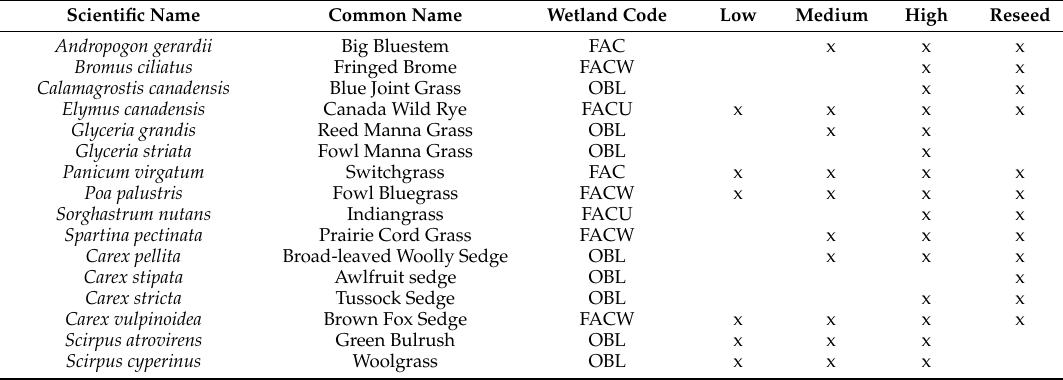
Table 2. List of plant species planted in the treatment wetland in 2013. High, medium, and low diversity seed mixtures are indicated along with a 23-species mixture for reseeding. Wetland code refers to the wetness tolerance of plant